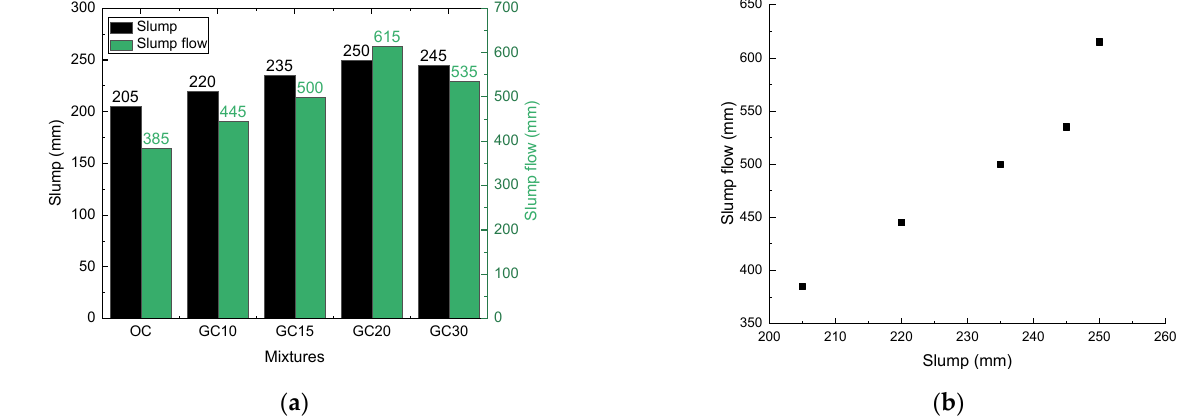
Figure 7. Slump and slump flow for different mixtures: ( a ) slump and slump flow values; ( b ) relationship between slump and slump flow.